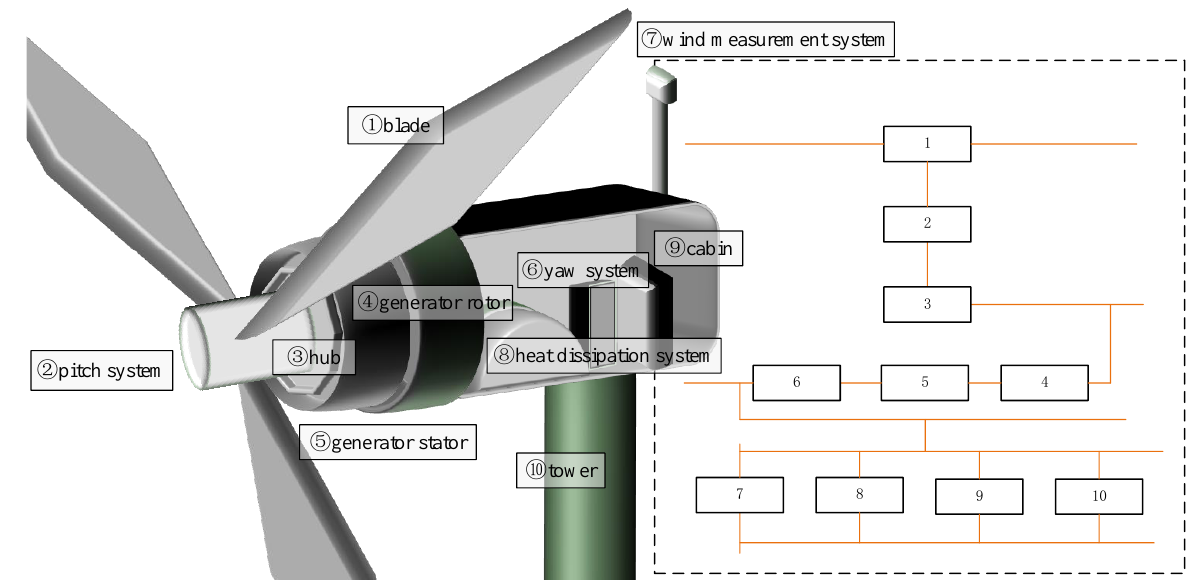
Figure 2. A wind turbine system with multiple components.